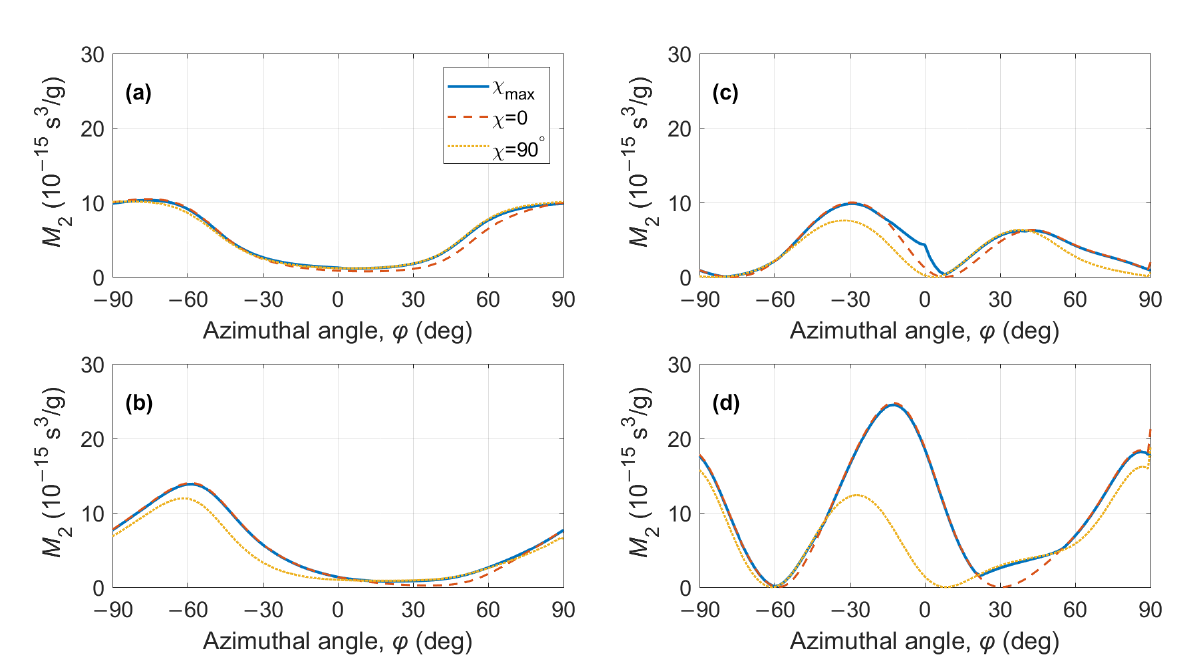
Figure 8. KYW crystal, AO figure of merit for acoustic propagation on the XY plane ( θ = 90 ◦ ): ( a ) QL BAW mode, fast optical mode; ( b ) QL BAW mode, slow optical mode; ( c ) QS BAW mode, fast optical mode; ( d ) QS BAW mode, slow optical mode. Solid lines—data from Figure 6; dashed and dotted lines—calculation according to Equations